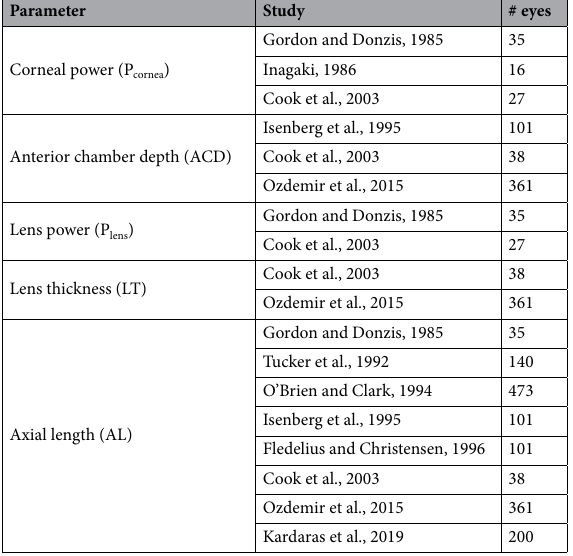
Table 1. List of studies measuring ocular parameters in preterm